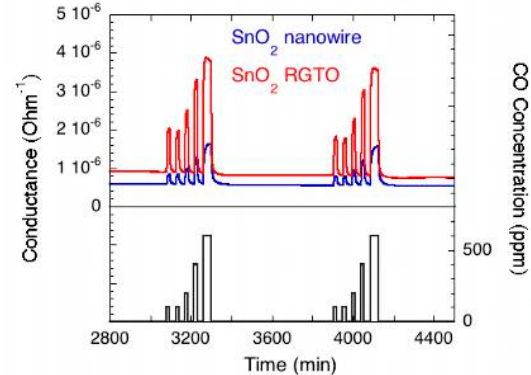
Figure A2. Test protocol employed to assess the long-term performance of SLV and RGTO-deposited SnO 2 materials.